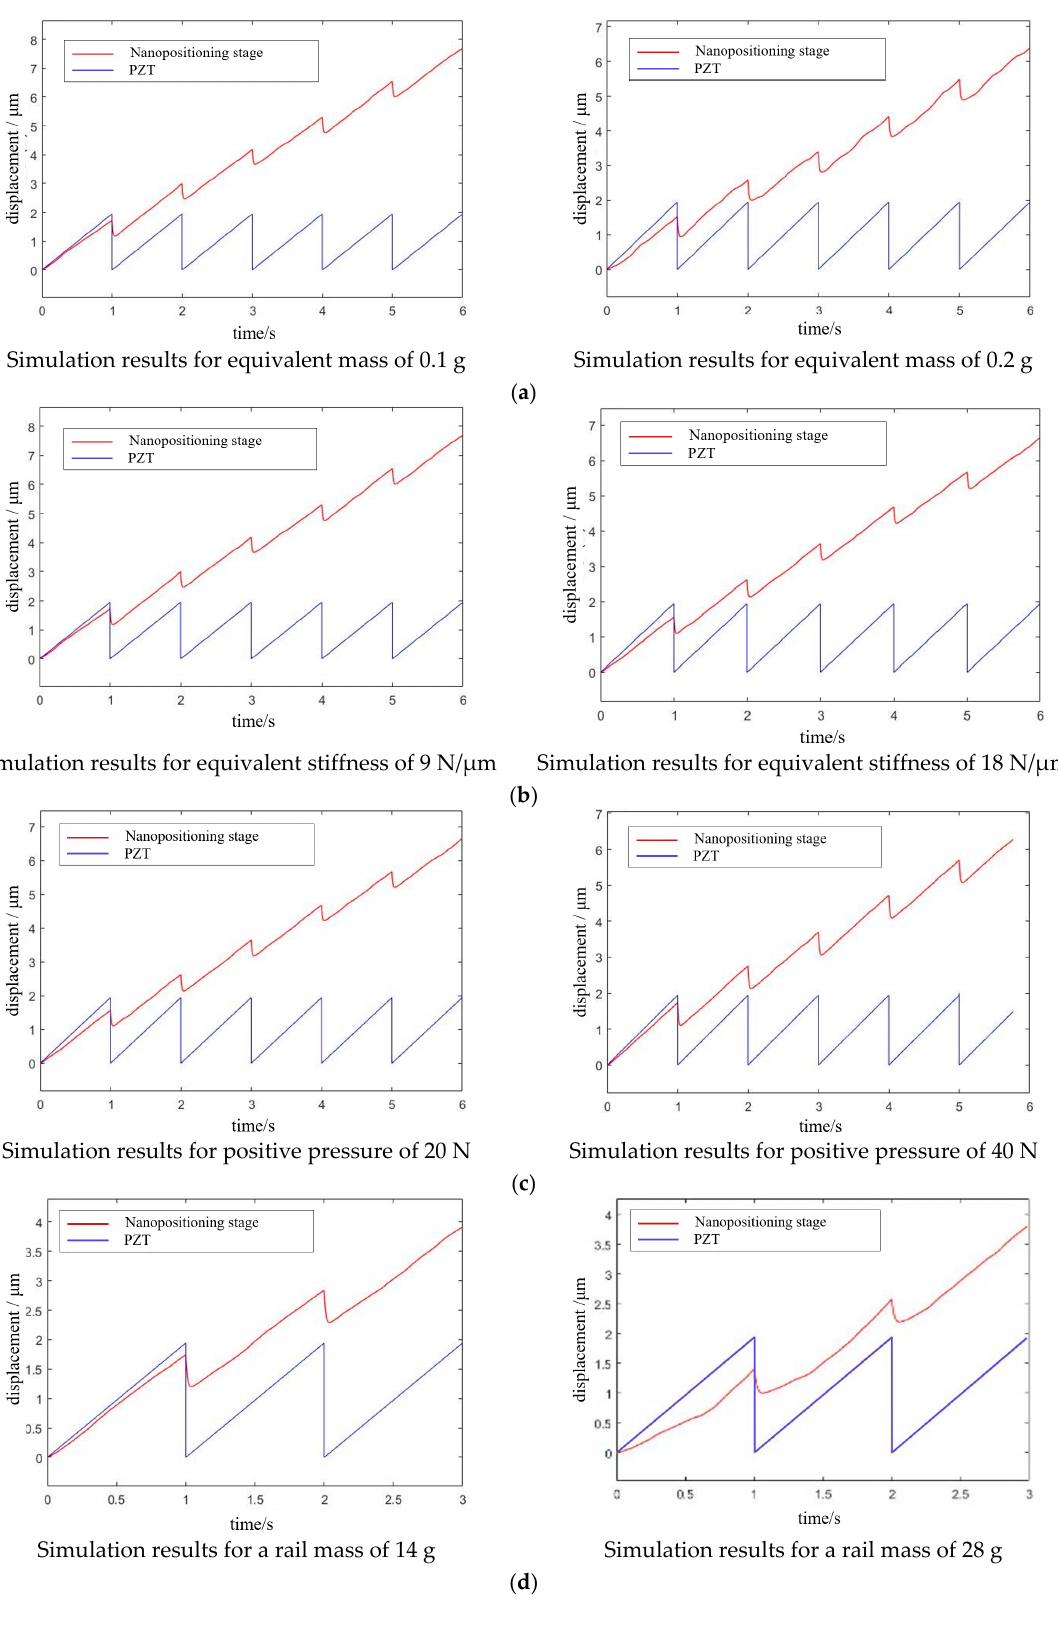
Figure 5. Effect of different parameters on the output displacement of the positioning stage: ( a ) effect of change in equivalent mass of flexible hinge; ( b ) effect of change in equivalent stiffness of flexible hinge; ( c ) effect of change in positive pressure providing friction; and ( d ) effects of changes in the quality of the guide rails.